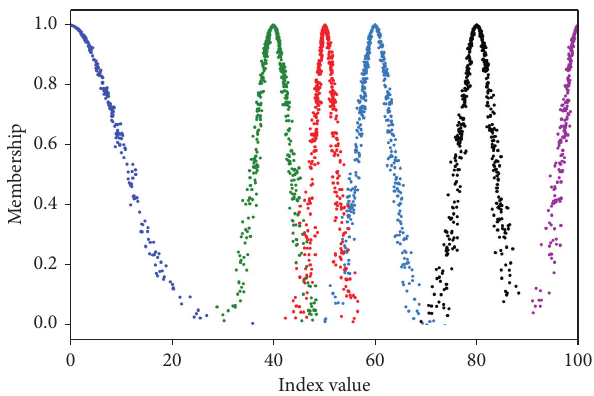
Figure 9: Cloud map of ecological risk.